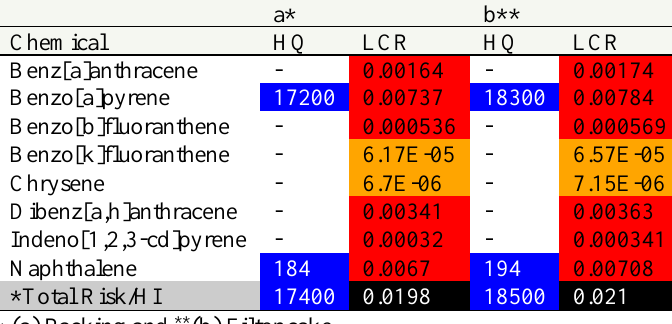
Table 9. LCR and HQ of PAHs based on type of